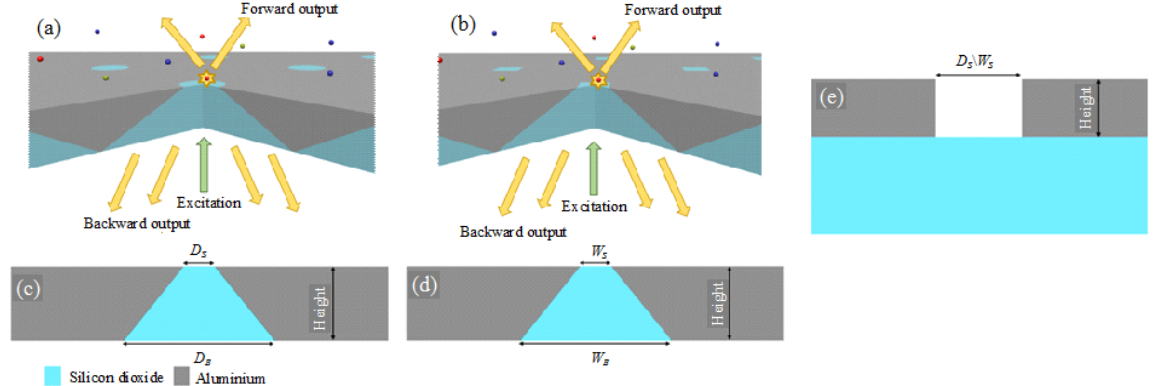
Fig. 1 Operational layout of the device and architectural schematic diagrams: (a) schematic diagram of the NFS using conical morphology (side view), (b) pyramidal morphology along with the molecules, (c) 2-dimensional (2D) schematic diagram of the NFS showing various dimensions of the structure for the conical morphology, (d) pyramidal morphology, and (e) 2D schematic diagram showing a comparable ZMW with a height equivalent for the corresponding NFS, and a width equivalent to D s for a conical morphology and W s for a pyramidal